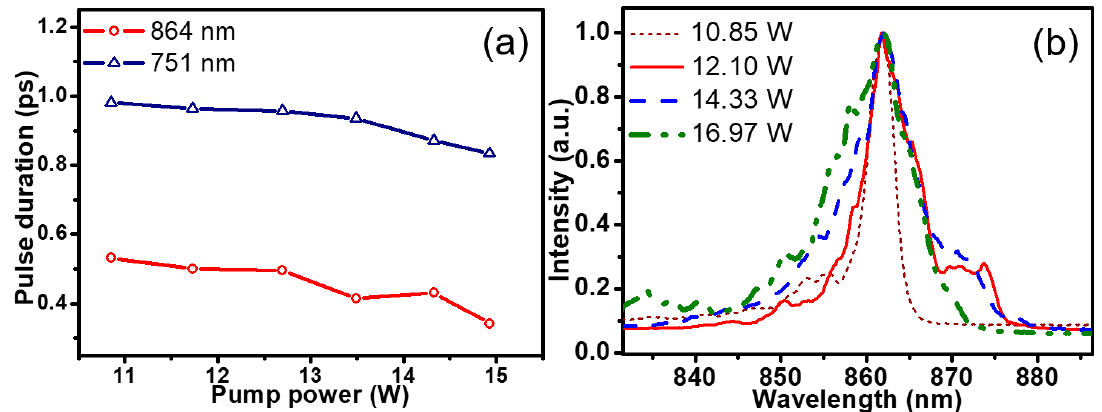
Figure 5. ( a ) The pulse duration of parametric waves as pump power increased. ( b ) Spectra for the parametric wave centered at 864 nm with different pump power levels. The spectra were taken by HR4000 with bandpass filters with 40 nm transmission band. The pulse duration in ( a ) was retrieved by hyperbolic secant fitting.